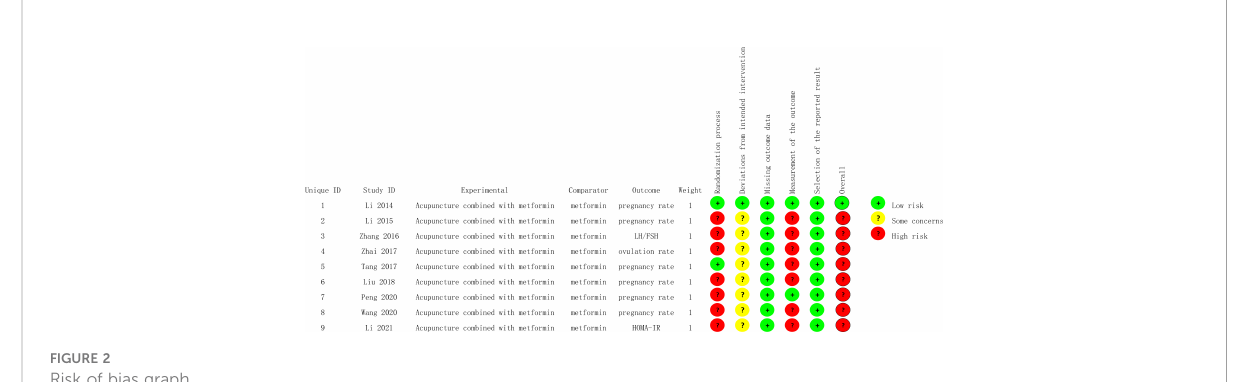
FIGURE 2 Risk of bias